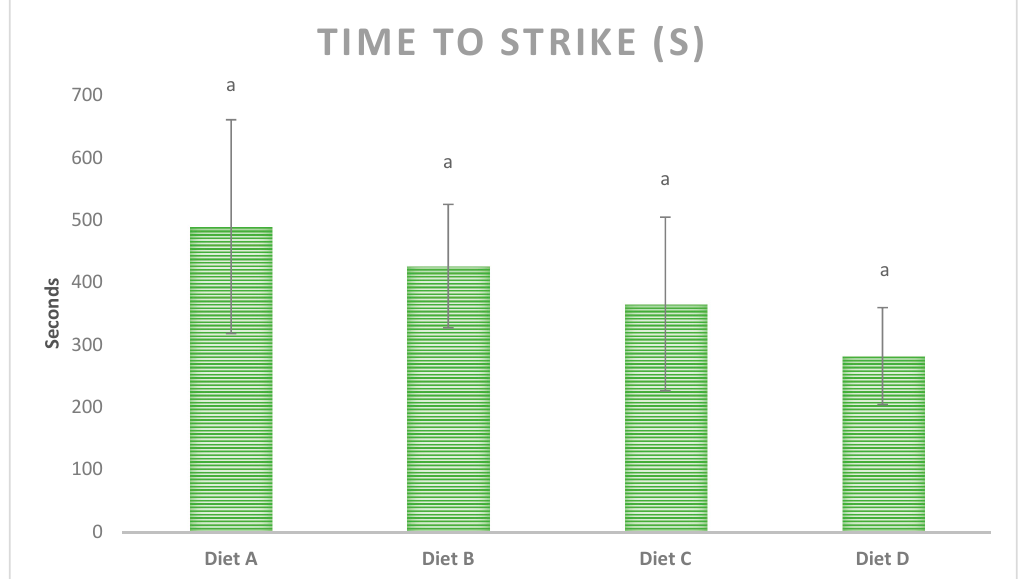
Figure 1. Time taken by the first shrimp to begin feeding (time to strike) for diets used in this study. Data is presented as mean ± standard deviation ( n = 5). Different letters in the same row indicate significant differences ( p < 0.05). Diet A: containing no palatability enhancers (control); diet B: containing squid meal and krill oil; diet C: containing 1% insect protein hydrolysate; diet D: contain 2% insect protein hydrolysate.